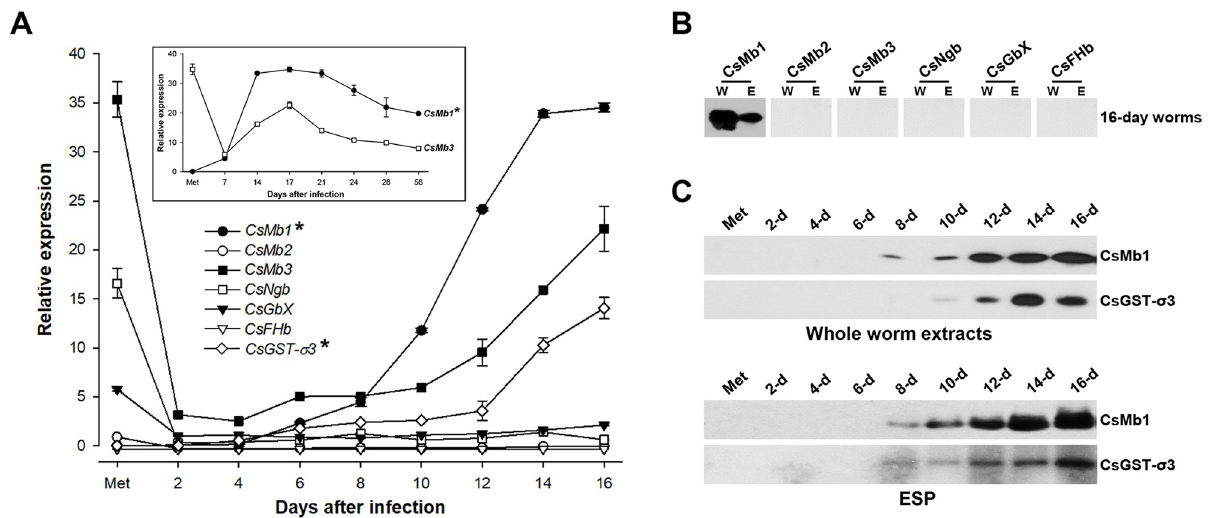
Fig 3. Temporal expression profiles of Clonorchis sinensis globin genes. A. Induction profiles of the Clonorchis sinensis globin genes were assessed using a quantitative PCR (qPCR) method related to the development/maturation of the liver fluke from metacercariae to 16-day worms. The calculations are based on independent technical triplicates (n = 3, mean ± S.D.). In cases of the CsMb1 and CsMb3 genes, worms up to 56 days-old were included in the measurements (inset graph). The relative expressions of CsMb1 and CsGST-σ3 (marked by asterisks) are given in 1/1,000 of their original values in the graphs. B . Western blot analysis of the whole worm extracts (W, 30 μ g/well) of C . sinensis adults and their excretory-secretory products [ESPs (E), 10 μ g/well] with antibodies specific to C . sinensis globins. C. The temporal secretion profile of CsMb1 was similarly examined in the whole body extracts and the ESPs of C . sinensis worms from metacercaria to 16 days post-infection. The anti-CsGST- σ 3 antibody was also included in the blotting analyses.